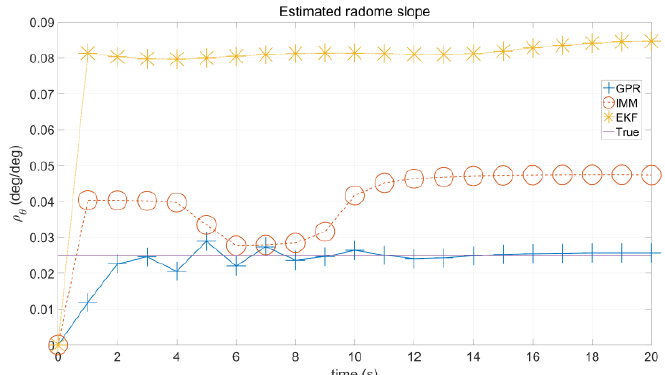
Figure 13. Estimation of radome slope via extended Kalman filter (EKF), interacting multiple-model (IMM) estimator and the proposed Gaussian process regression (GPR)-based method.